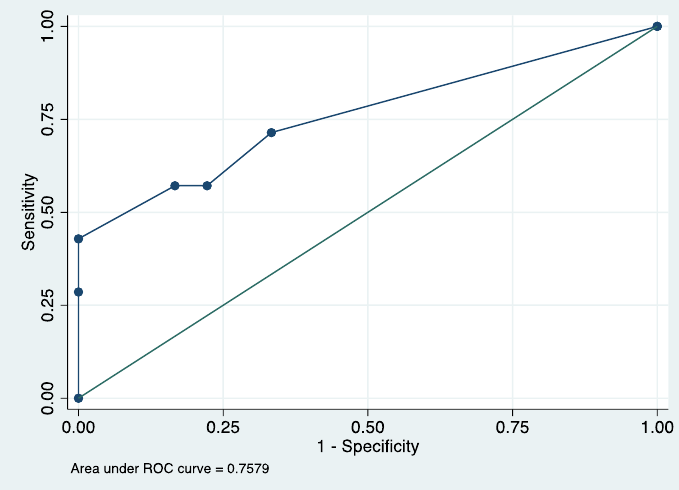
Figure 3. Predictive value of the background score at aEEG, ROC curve.